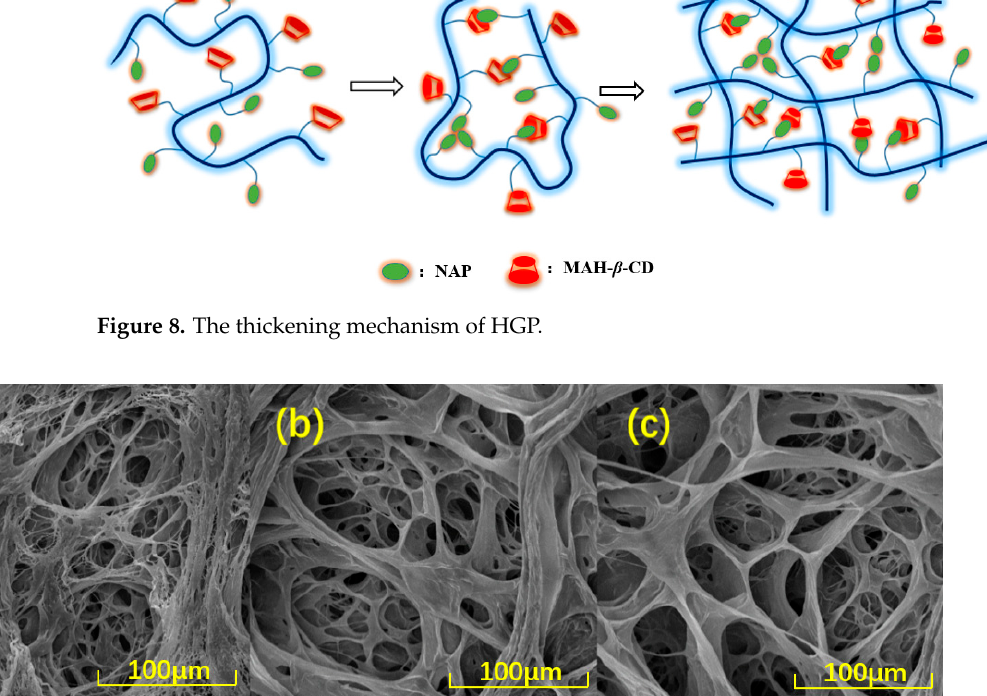
Figure 9. SEM morphologies of 0.6 wt.% GP-T, HP-T, and HGP in DI water (1000×). ( a ) HGP, ( b ) HP-T, ( c ). GP-T.